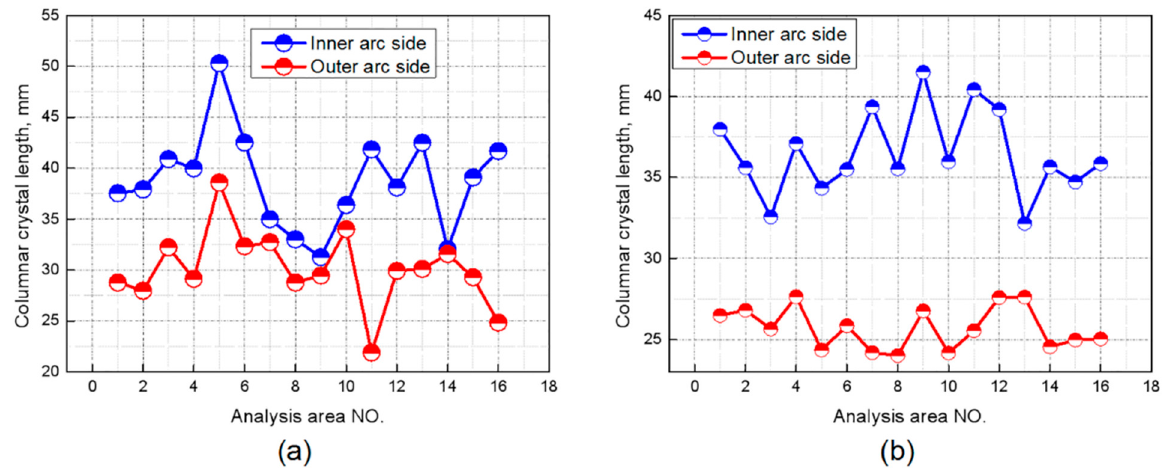
Figure 11. Measured columnar crystal length in inner and outer arc side of billet No. 1 ( a ) and No. 2 ( b ). Table 5. Variation coefficient of columnar crystal length of billet No. 1 and No. 2. Characteristics